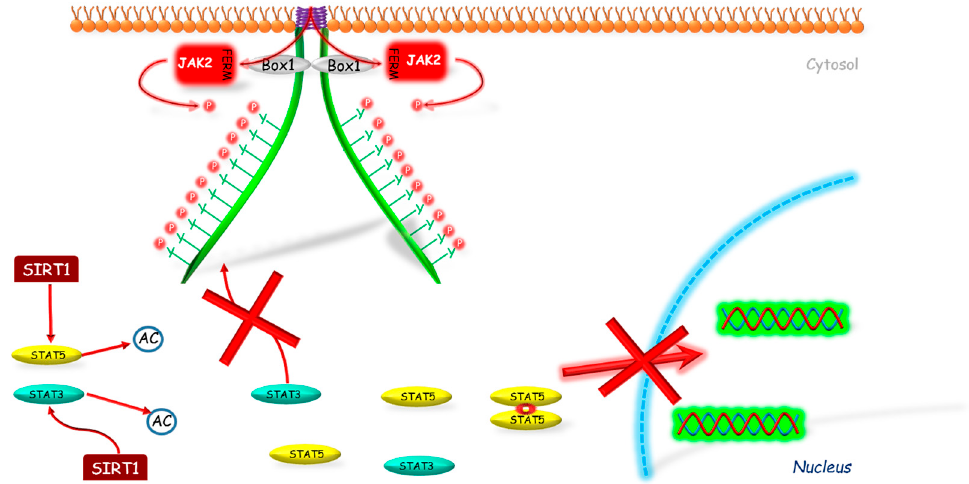
Figure 3. The mechanism of SIRT1 inhibition of JAK2-STAT pathway. SIRT1 interacts with STAT3